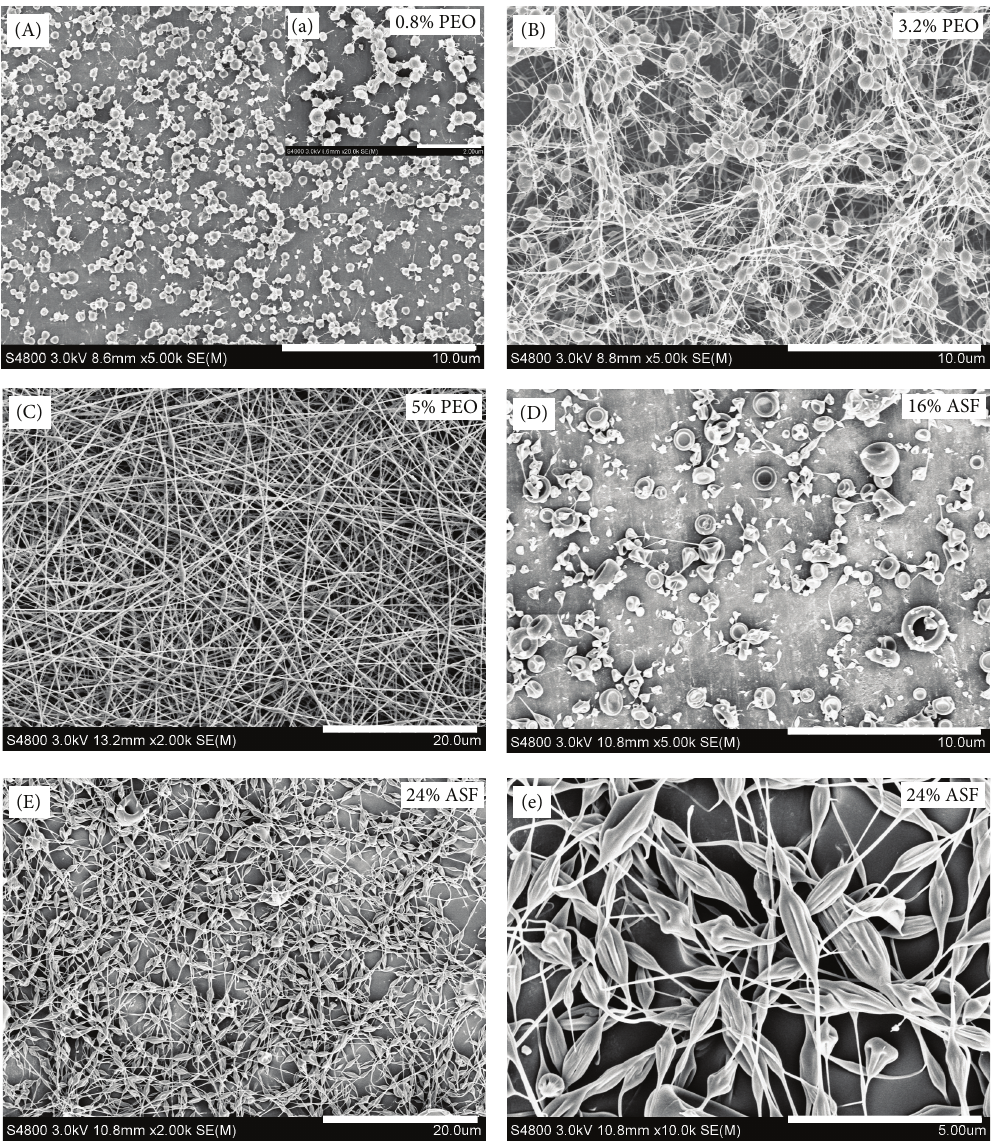
Figure 1: SEM images of electrospun products from various solutions: (A, a) 0.8 wt% PEO, (B) 3.2% PEO, (C) 5.0% PEO, (D) 16.0% ASF, (E) 24.0% ASF, and (e) magnified image of image (E). Scale bars: (A, B, D) 10 𝜇 m, (a) 2 𝜇 m, (C, E) 20 𝜇 m, and (e) 5 𝜇